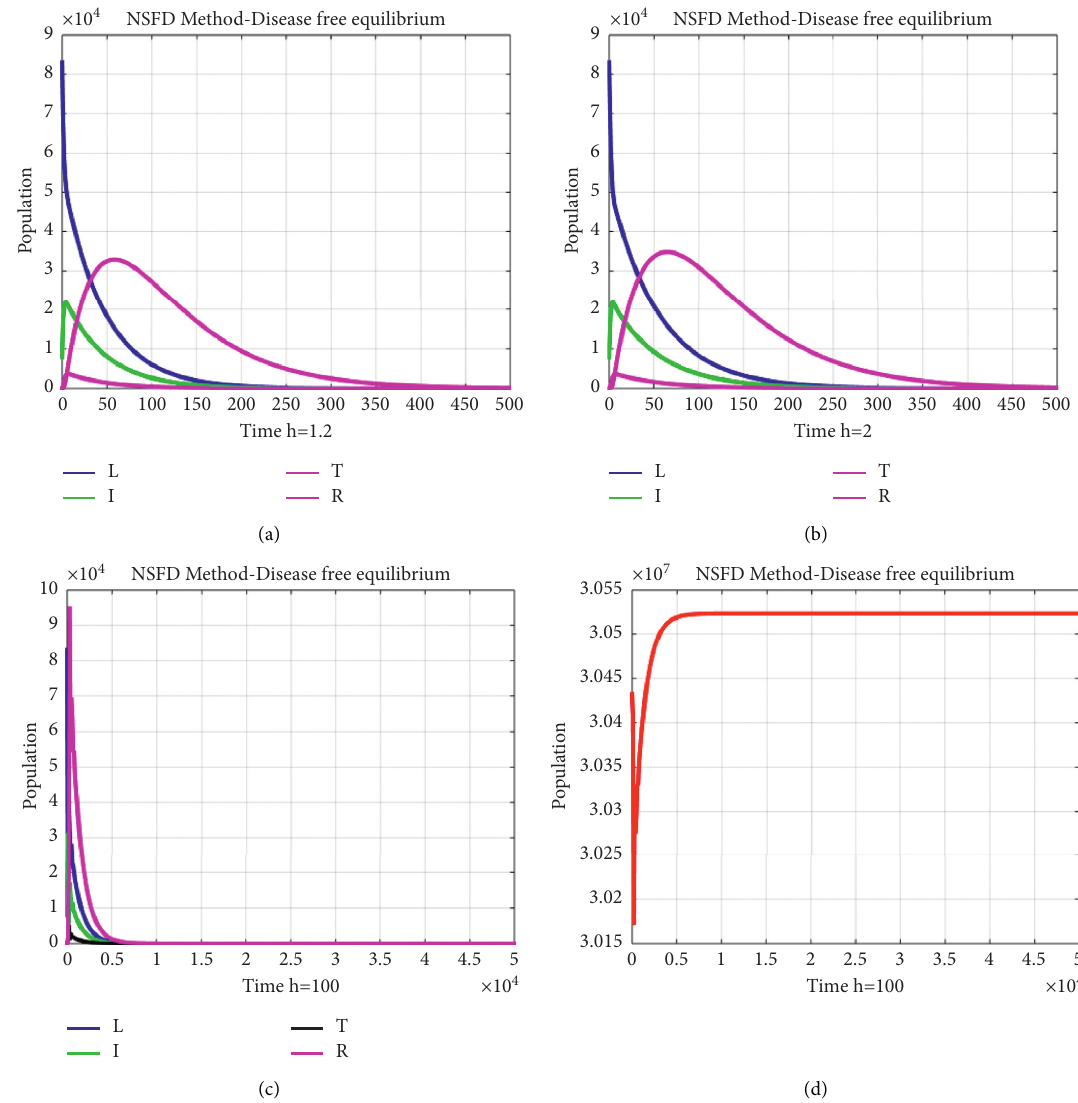
Figure 3: Simulations of forward Euler at endemic equilibrium for step size h � 1 . 2 and h � 2. (a) Simulations of NSFD. (b) Simulations of NSFD. (c) Simulations of NSFD. (d) Simulations of